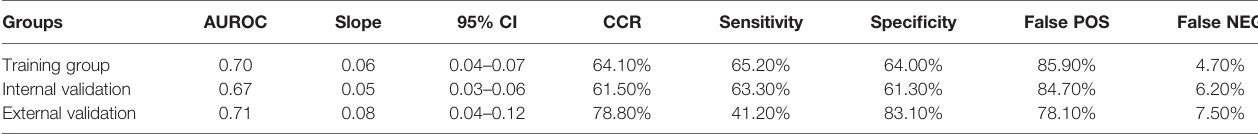
TABLE 3 | Evaluation of the discrimination ability of the